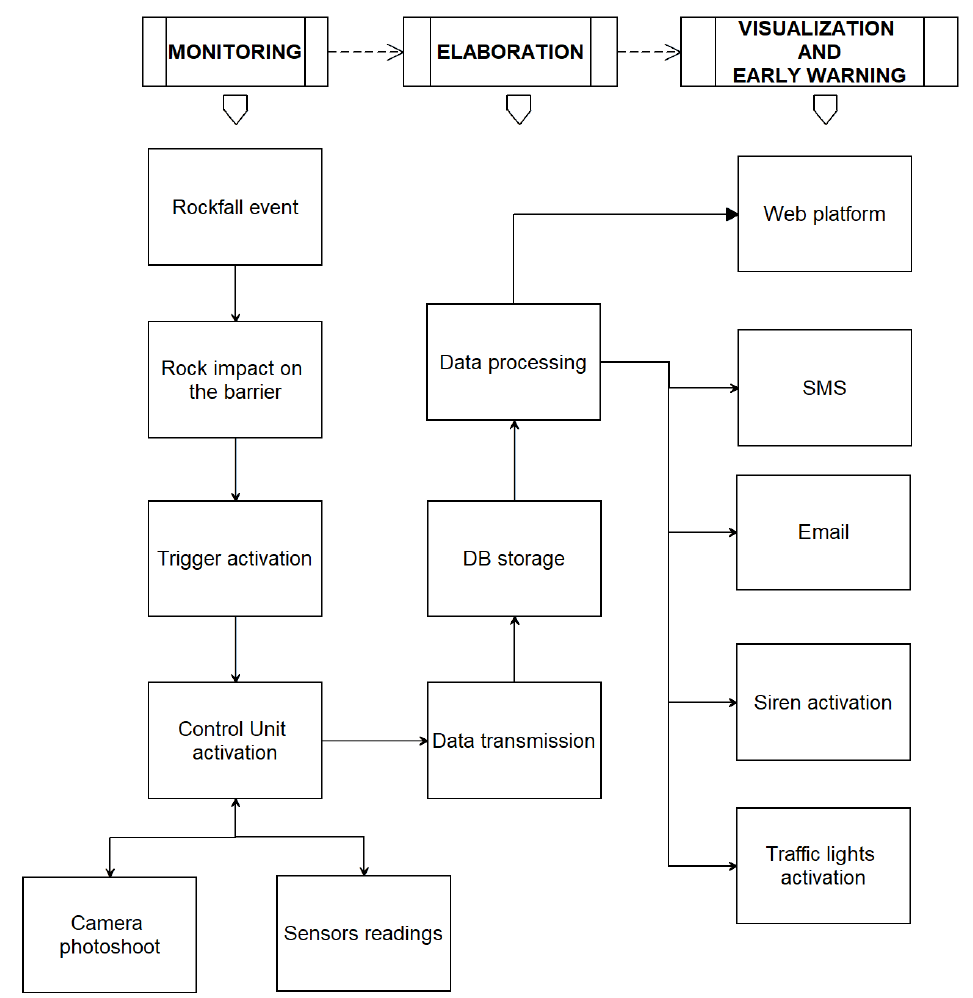
Figure 2. IoNH approach applied to a rockfall event and its impact on protection barriers, followed by trigger activation, data collection and transmission, database storage, data processing, and activation of warning